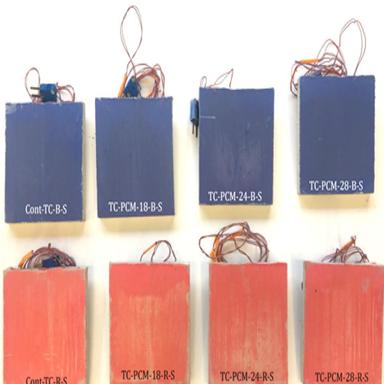
Developed Type 2 cement plaster samples.